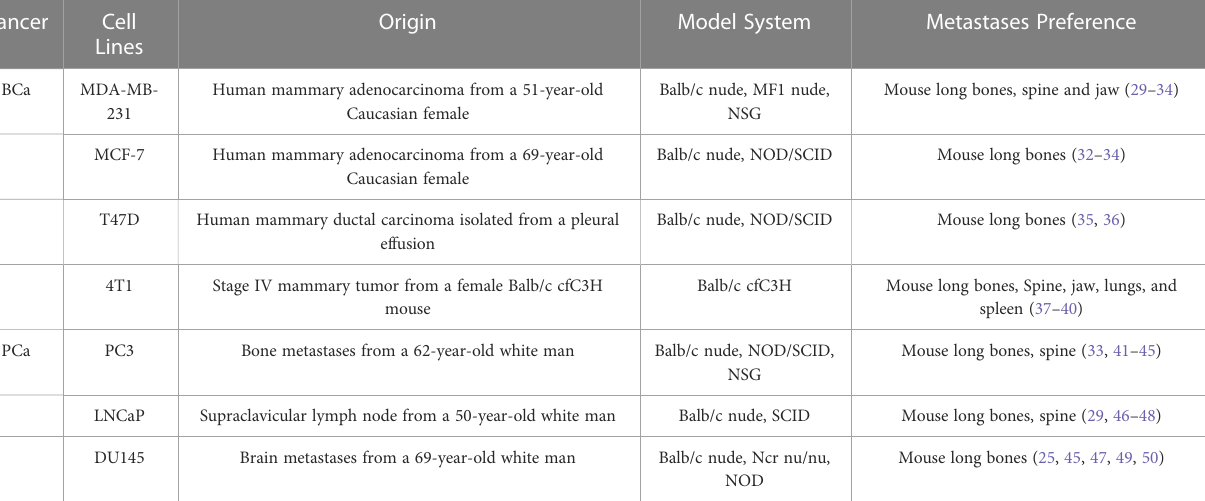
TABLE 1 Common cancer cell lines in bone